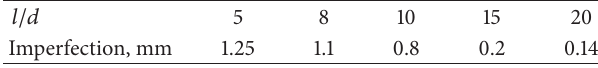
Table 1: Initial imperfections used in the buckling models.